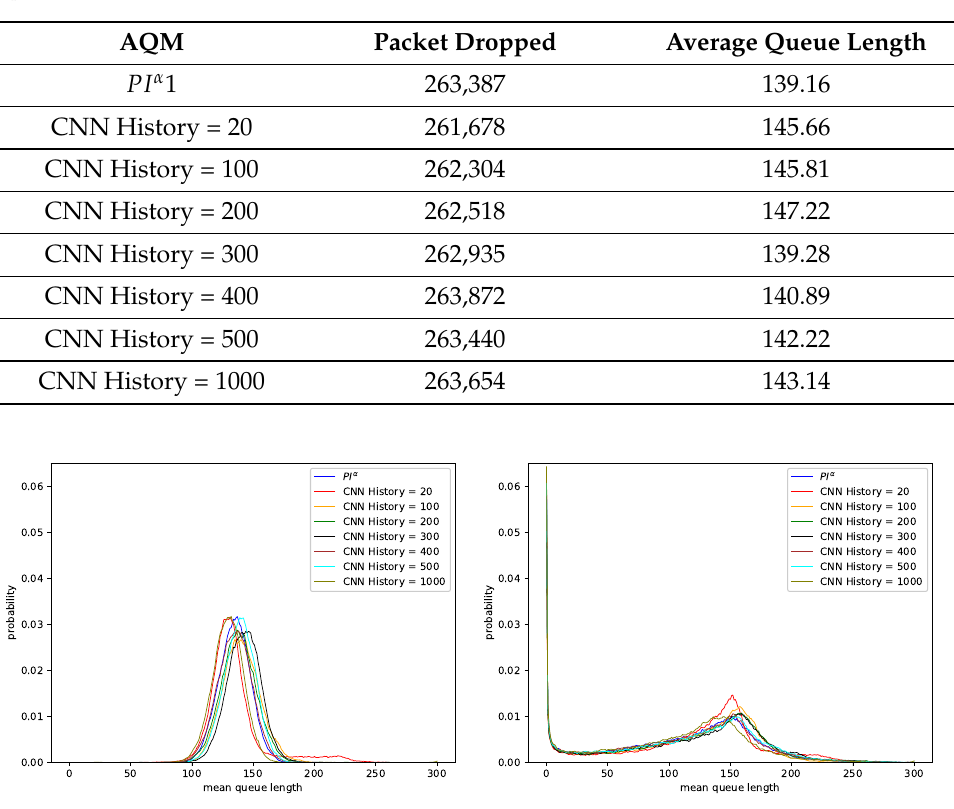
Table 7. Detailed results of queue occupancy obtained for CNN model with the last layer activation function Sigmoid, trained using data regarding PI α 1 controller and parameters: K P = 0.0001, K I = 0.0004, α = − 0.4 and H = 0.9.